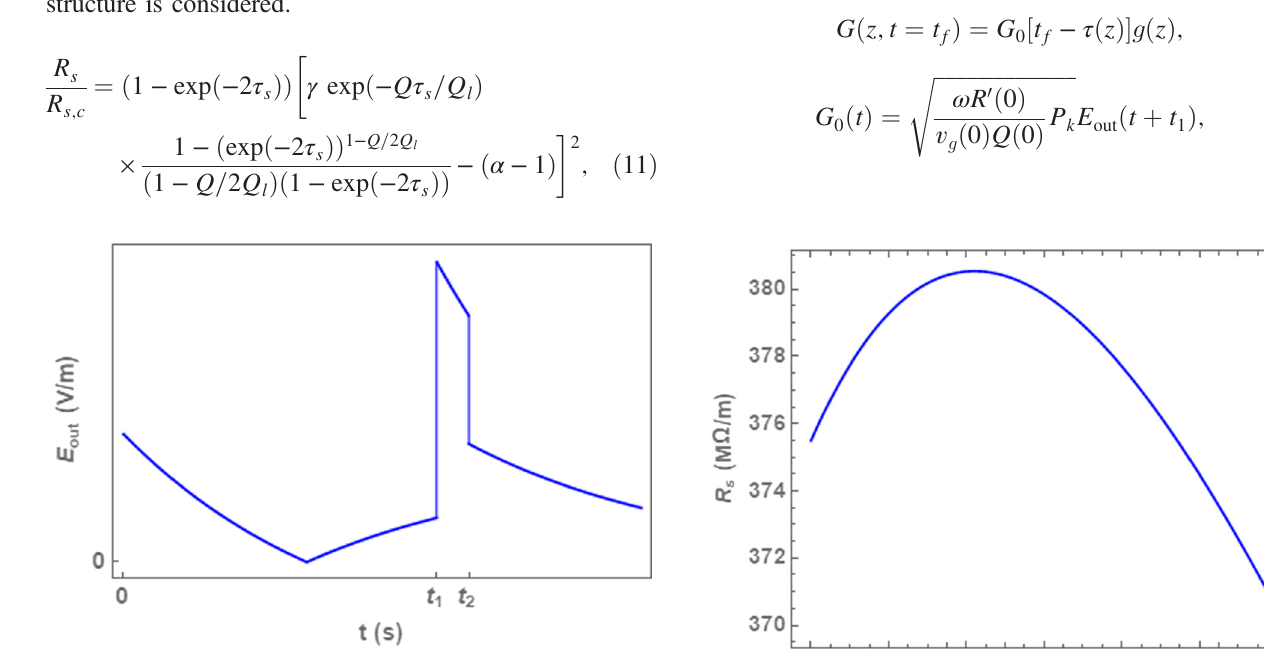
FIG. 9. The output rf pulse profile from the SLED system which increase the power flow toward the accelerator. The klystron is phase shifted by 180 degrees at time t 1 and the total length of the klystron pulse is given by t 2 .